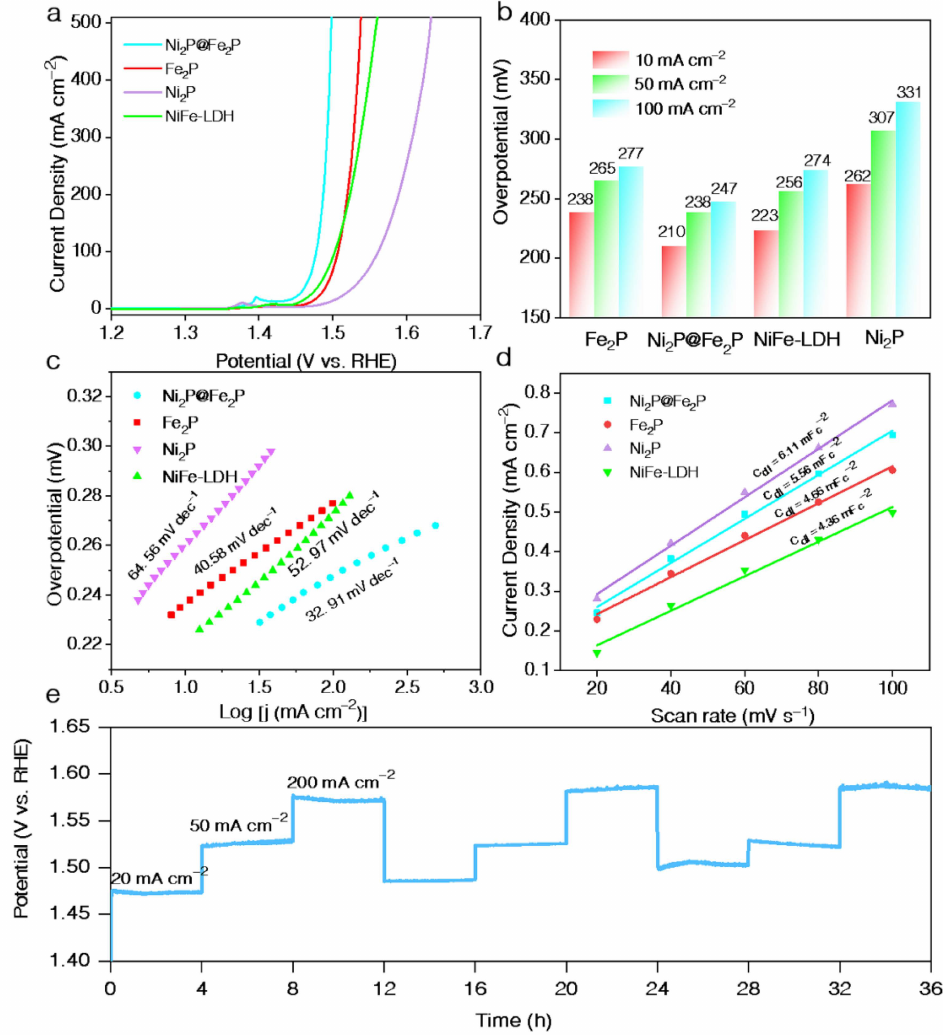
Figure 4. ( a ) LSV curves of Fe 2 P, Ni 2 P@Fe 2 P, NiFe-LDH and Ni 2 P. ( b ) Comparison of the over- potentials at 10 mA cm − 2 , 50 mA cm − 2 and 100 mA cm − 2 for Fe 2 P, Ni 2 P@Fe 2 P, NiFe-LDH